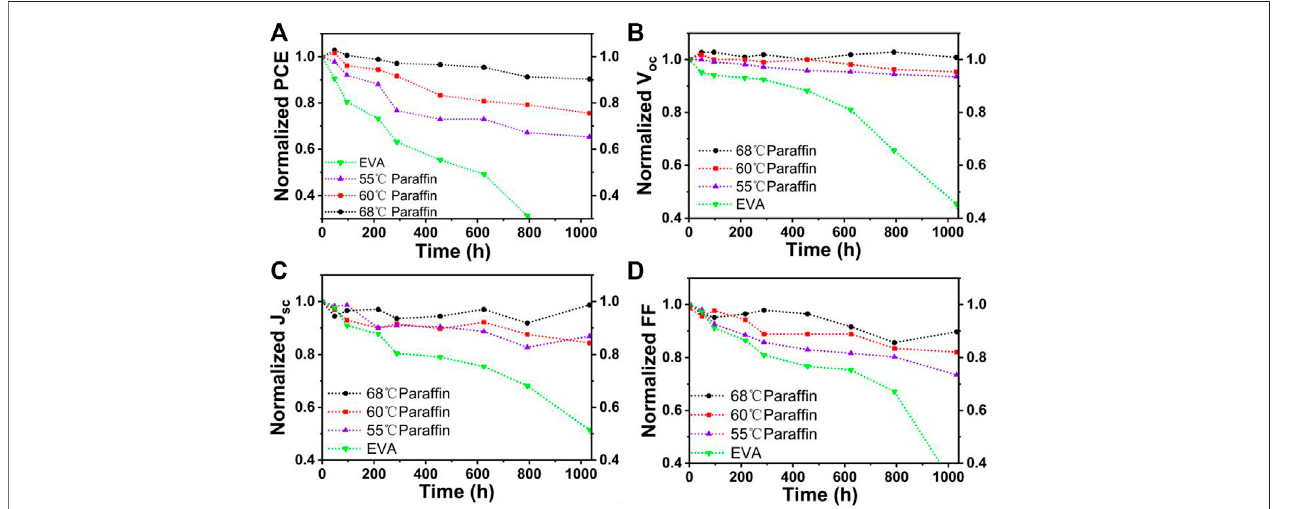
(B) , J (C), and FF oc SC